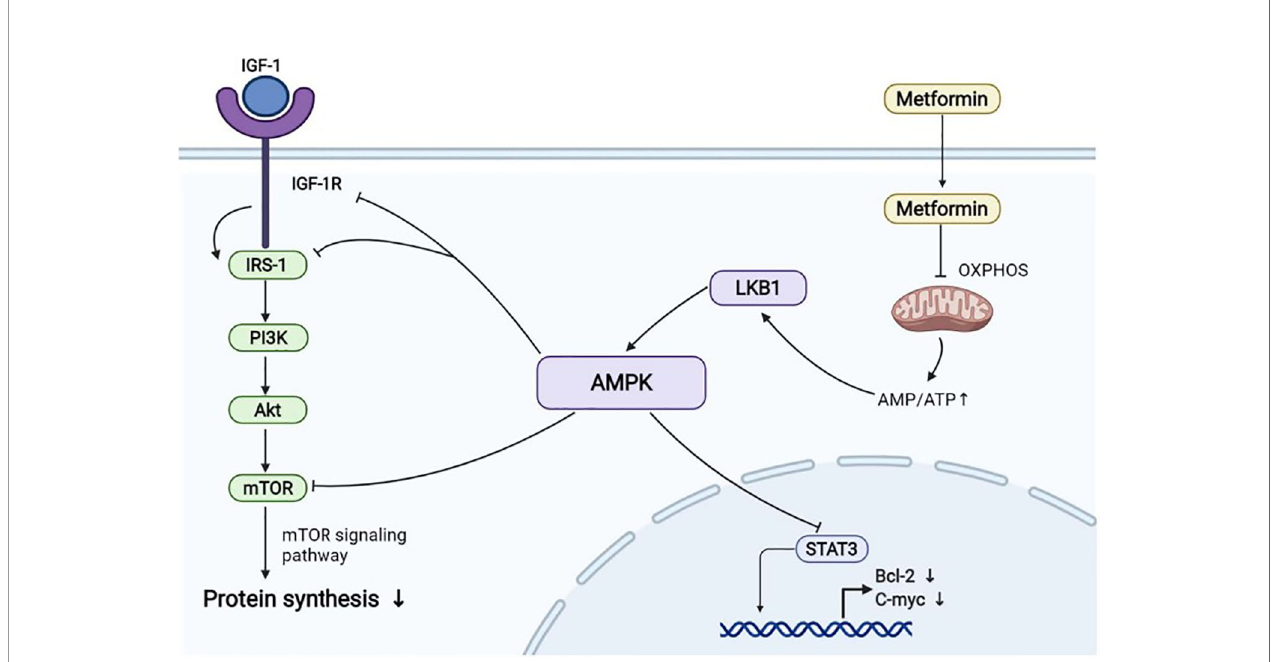
FIGURE 2 | Some of the molecular mechanisms by which metformin inhibits cancer. (Created from